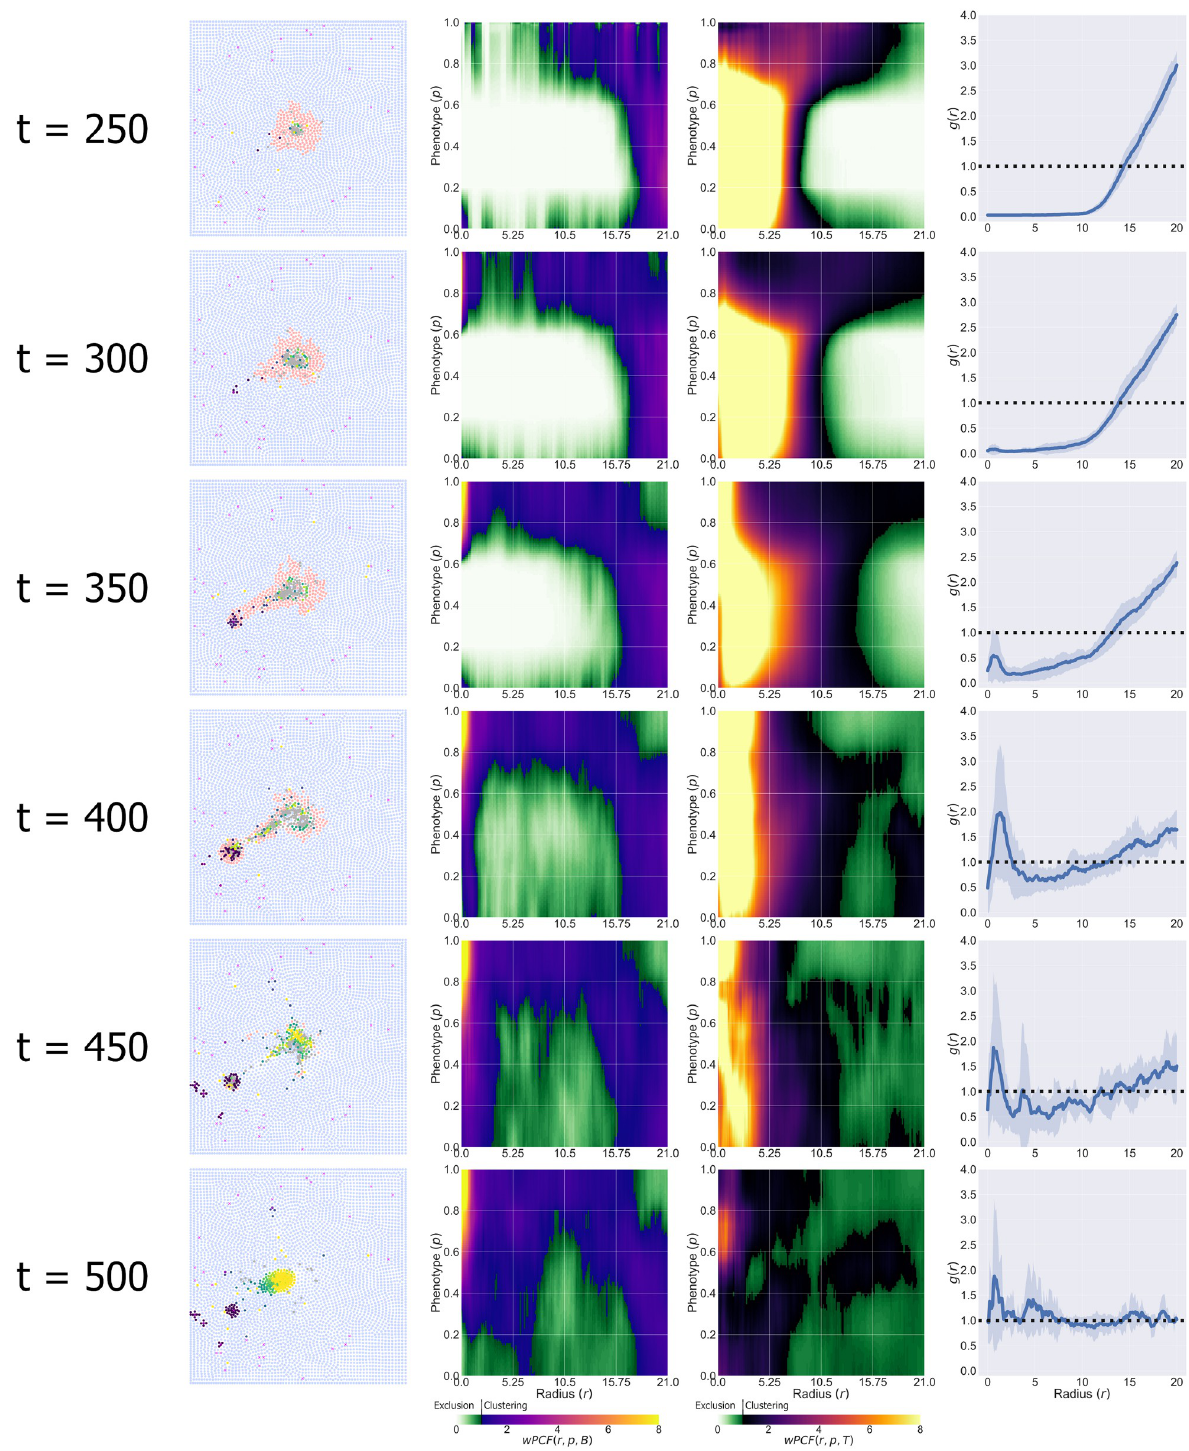
Fig 8. Dynamic evolution of an ABM simulation. Time series showing the evolution of an ABM simulation generated with w m and all other parameter values fixed at the default values listed in S1 Appendix. At different timepoints, the simulation exhibits behaviours which are consistent with Equilibrium, Escape and Elimination. The corresponding PCF signatures show how the ABM progresses through these stages.